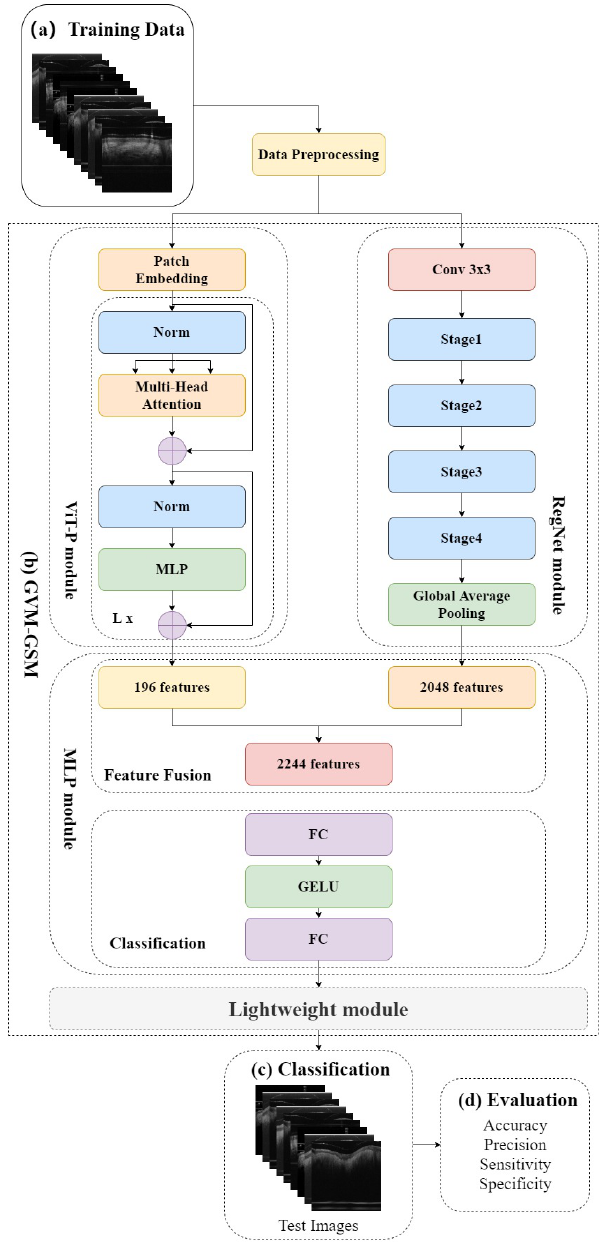
Figure 5. The structure of RVM-GSM. ( a ) shows the GSM-OCT image used to train the RVM-GSM; ( b ) shows the main body of RVM-GSM, which consists of three parts. First, RVM-GSM is designed to perform global and local feature extraction using ViT-P and RegNet modules. Then, feature fusion and classification are performed by the MLP module. In total, 196 features were captured by the ViT-P module and 2048 features were finally captured by the RegNet module. The 196 and 2048 features extracted by the ViT-P module and RegNet module are first fused in the MLP module to generate 2244 features. Then, MLP is applied for classification. Finally, the model is postprocessed as follows: lightweight module is used to achieve compression; ( c ) RVM-GSM is used to classify the test set images; ( d ) the performance of the RVM-GSM check is evaluated in terms of accuracy (ACC), precision, sensitivity and specificity